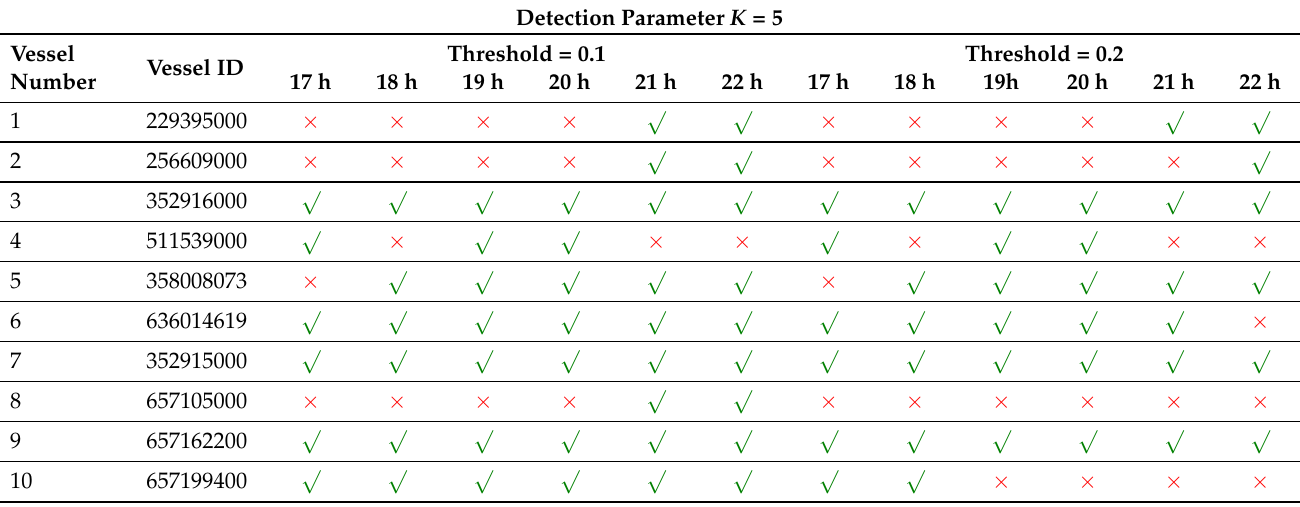
Table 1. Detection results for K = 5 and different threshold values in the selected period of time.